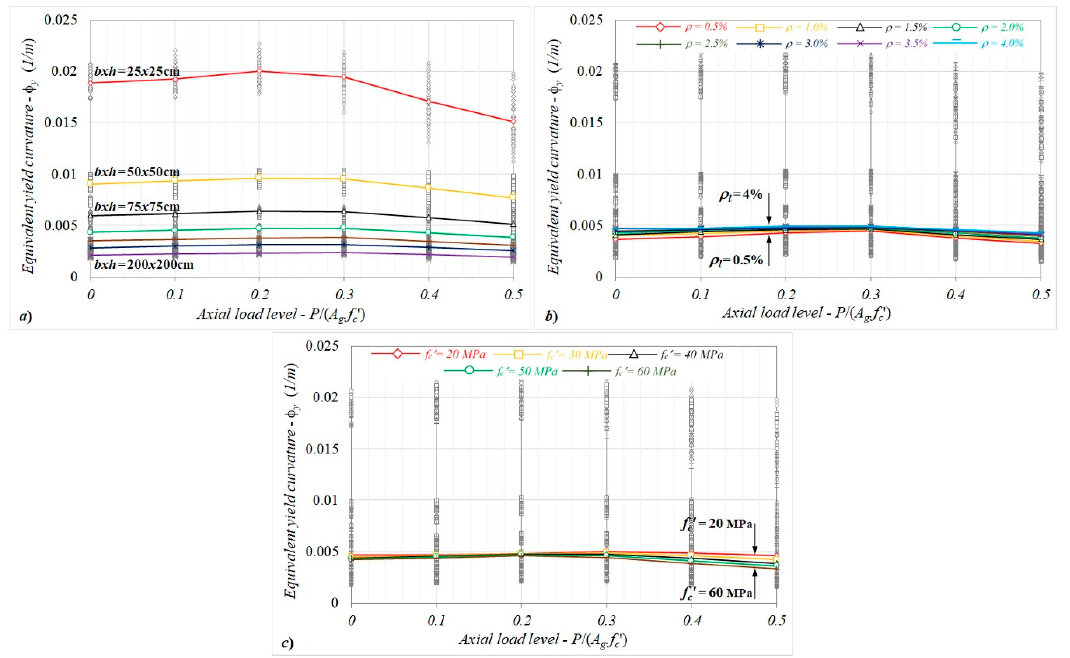
Figure 5. The variations of equivalent yield curvatures with the axial load level in terms of different a ) column dimensions, b ) reinforcement ratios, and c ) concrete compressive strengths.